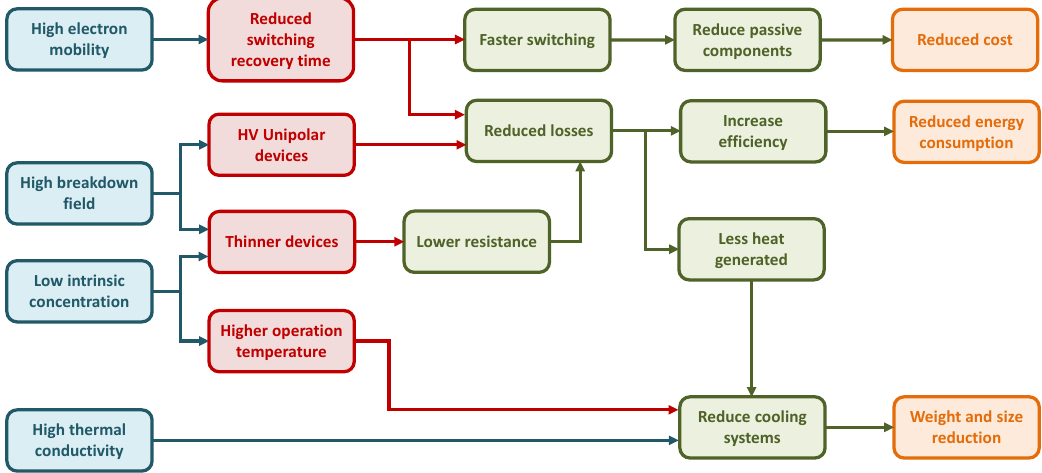
Figure 2. WBG semiconductor parameter capabilities (blue); physical properties affected by WBG advantages (red); power electronics characteristics (green); and product benefits